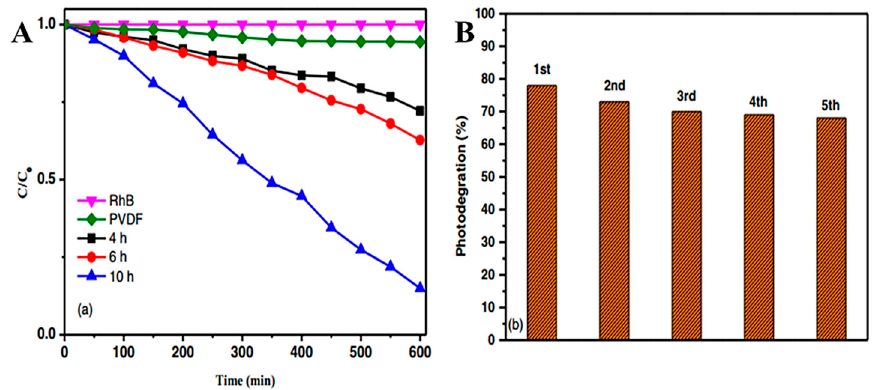
Figure 11. ( A ) Photodegradation profiles of rhodamine B over the samples: Rhodamine B without photocatalyst, PVDF and TiO 2 / PVDF composites hydrothermal treated for 4 h, 6 h, and 10 h. ( B ) The photocatalyst treated for 10 h was used for rhodamine B degradation, and the number of cycles was five times [167].